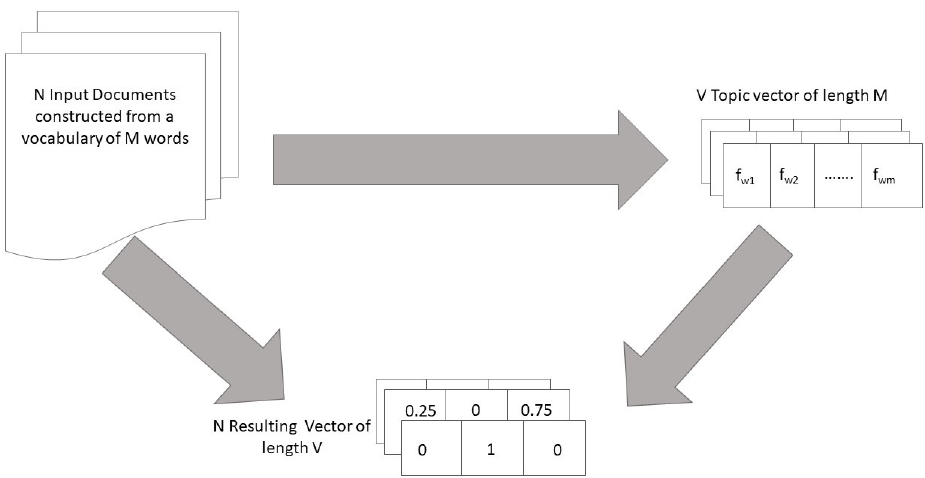
Figure 1. LDA Model